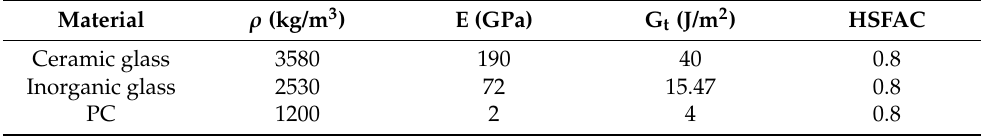
Table 1. The DG-PD material model parameters of the ceramics glass, inorganic glass, and PC.